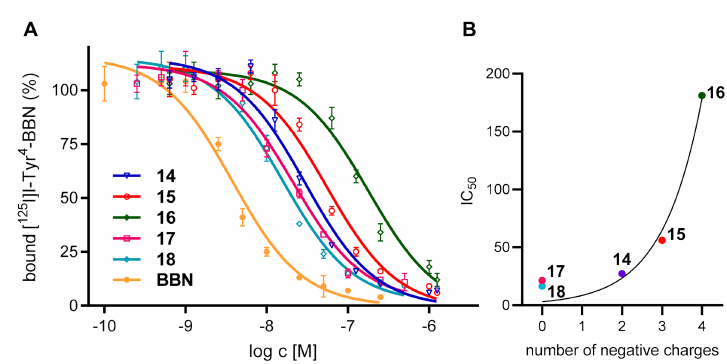
Figure 5. Results of the competitive displacement assays of the hybrid multimodal imaging synthon- bioconjugates 14 – 16 , the reference compounds 17 and 18 as well as bombesin (BBN) on stably GRPR-transfected human embryonic kidney 293 (HEK) cells using [ 125 I]I-Tyr 4 -bombesin as competitor. The 50% inhibitory concentration (IC 50 ) values for BBN (being used as internal standard with known high GRPR a ffi nity) and 14 – 18 were determined to be 2.81 ± 0.56 nM, 27.39 ± 2.01 nM, 56.07 ± 1.47 nM, 181.23 ± 2.45 nM, 21.48 ± 1.2 nM and 16.64 ± 1.06 nM, respectively ( A ). Correlation between IC 50 values and number of negative charges of 14 – 18 ( B